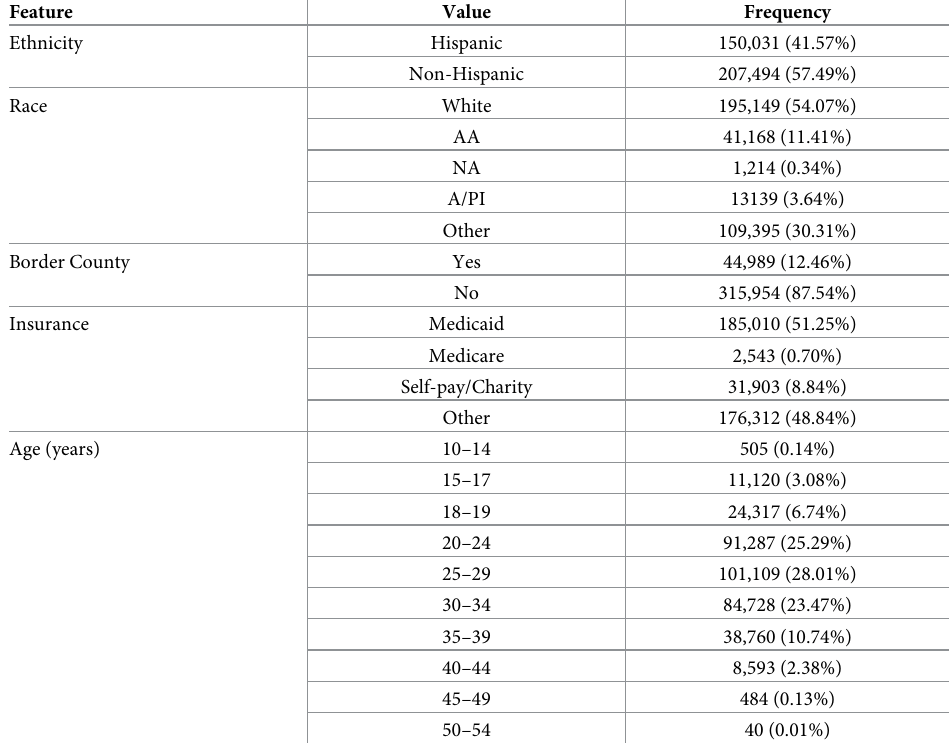
Table 2. Patient demographic attributes in the Texas PUDF, where AA: African American, NA: Native America, A/PI: Asian or Pacific Islander. Feature